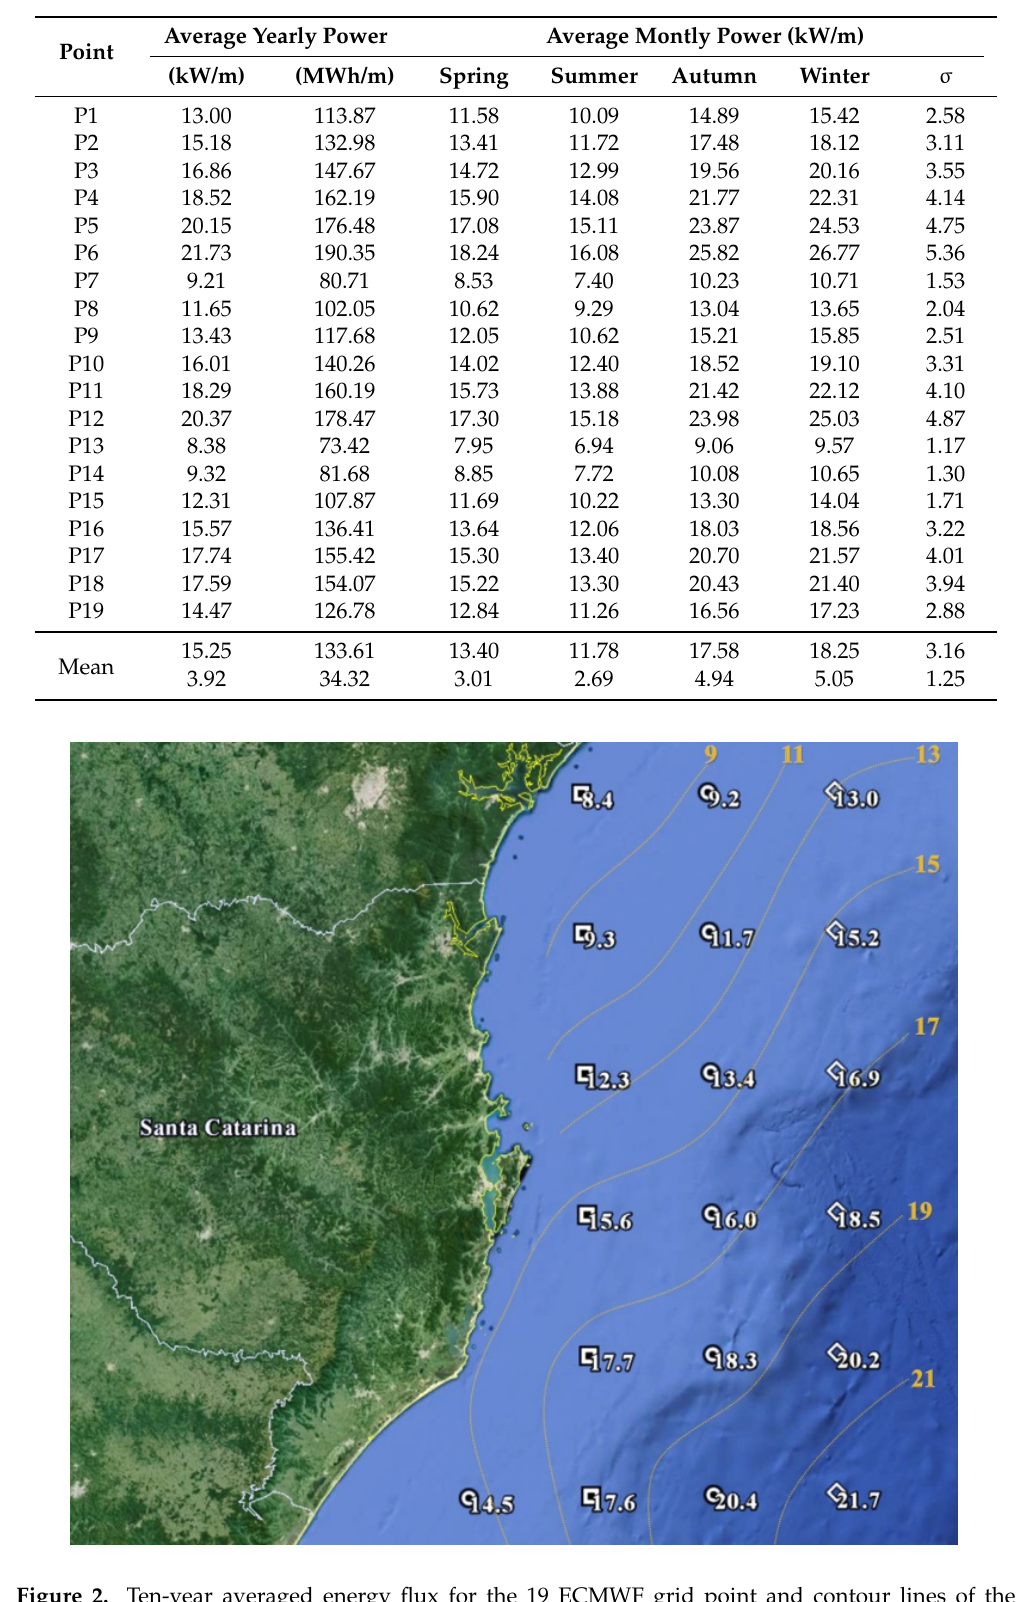
Figure 2. Ten ‐ year averaged energy flux for the 19 ECMWF grid point and contour lines of the Figure 2. Ten-year averaged energy flux for the 19 ECMWF grid point and contour lines of the estimated mean wave power flux per unit crest on the Santa Catarina coastline. estimated mean wave power flux per unit crest on the Santa Catarina